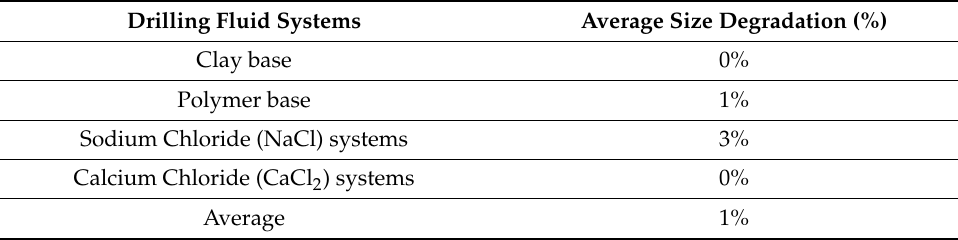
Table 6. Graphite size degradation (30 min shearing only).